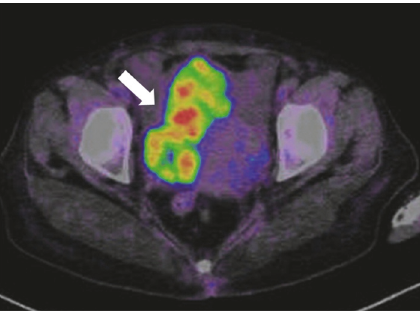
Figure 4: Posttreatment magnetic resonance imaging of our patient with endometriosis. PET/CT after eight years of treatment. Increased focal fludeoxyglucose accumulation(SUV max = 10.00) is observed in the solid elements of the right ovary (arrow).